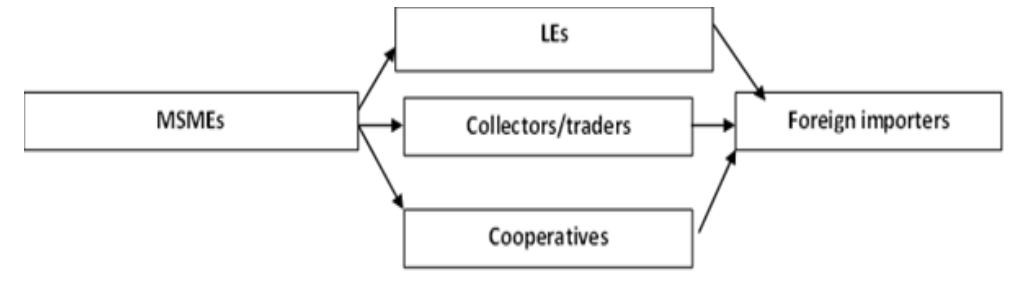
Figure 2: MSME Indirect Export Model in